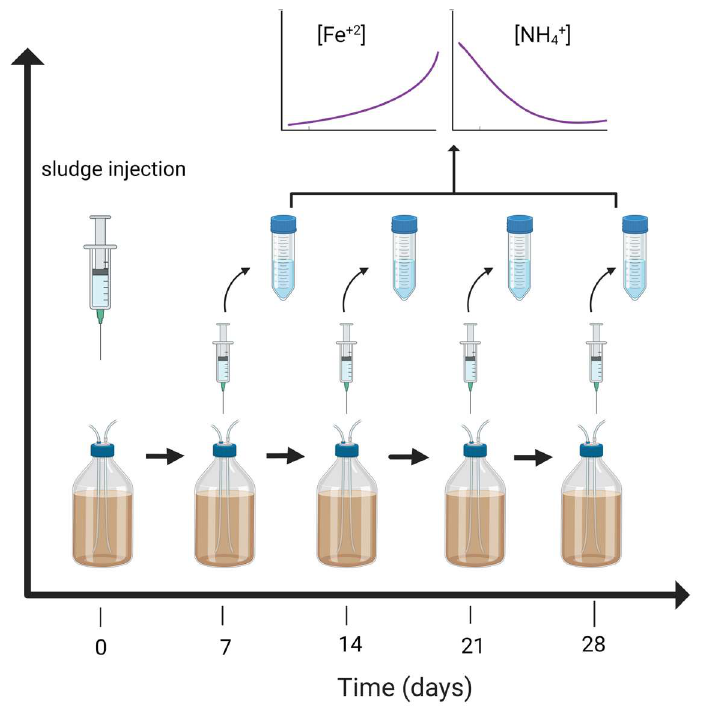
Figure 2. Batch reactor operating procedure. Created with BioRender.com (accessed on 15 December 2022)